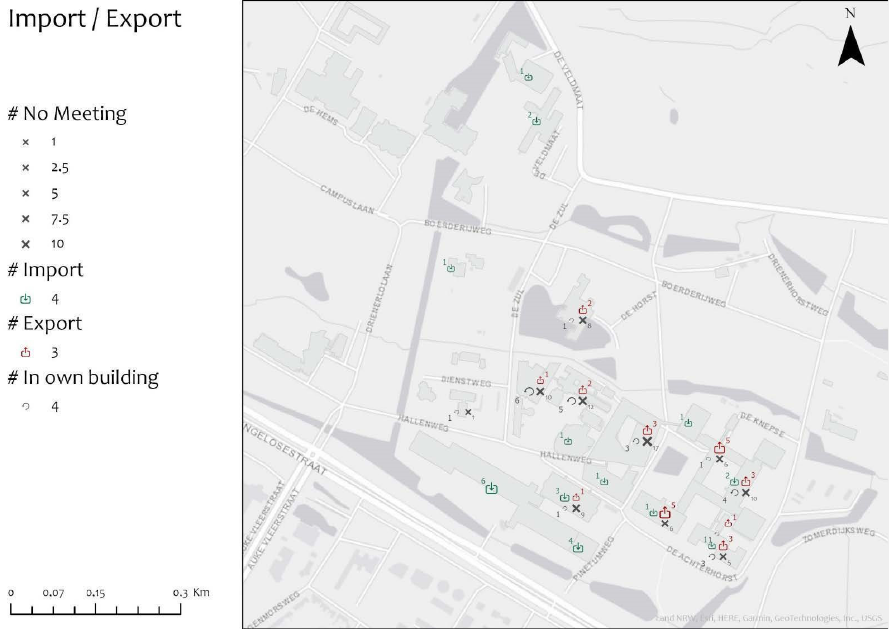
Figure A7. UT campus—import/export of unplanned meetings with companies. # = ‘Number of’. Int. J. Environ. Res. Public Health 2022 , 19 , x